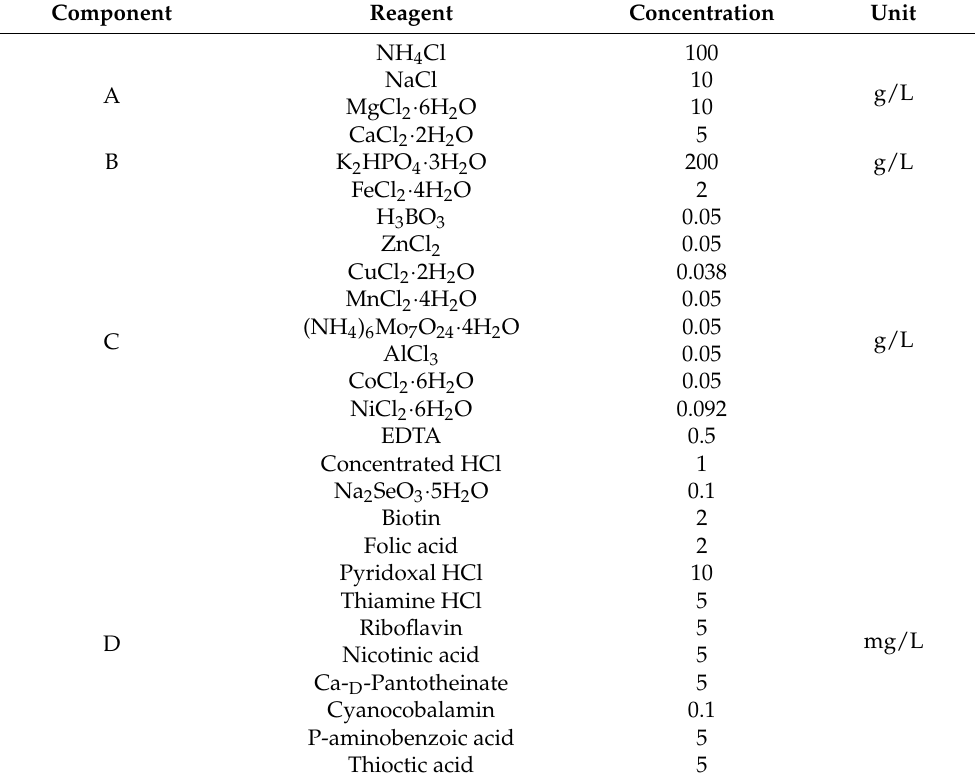
Table 1. Stock solution of basal anaerobic